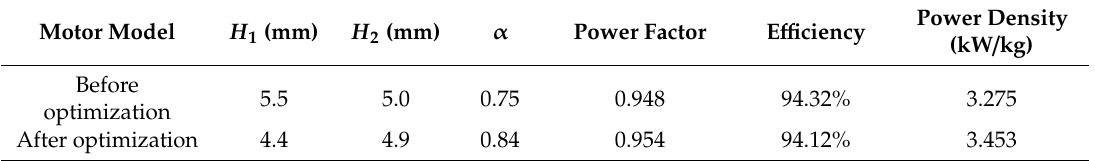
Table 3. Motor data comparison before and after optimization.